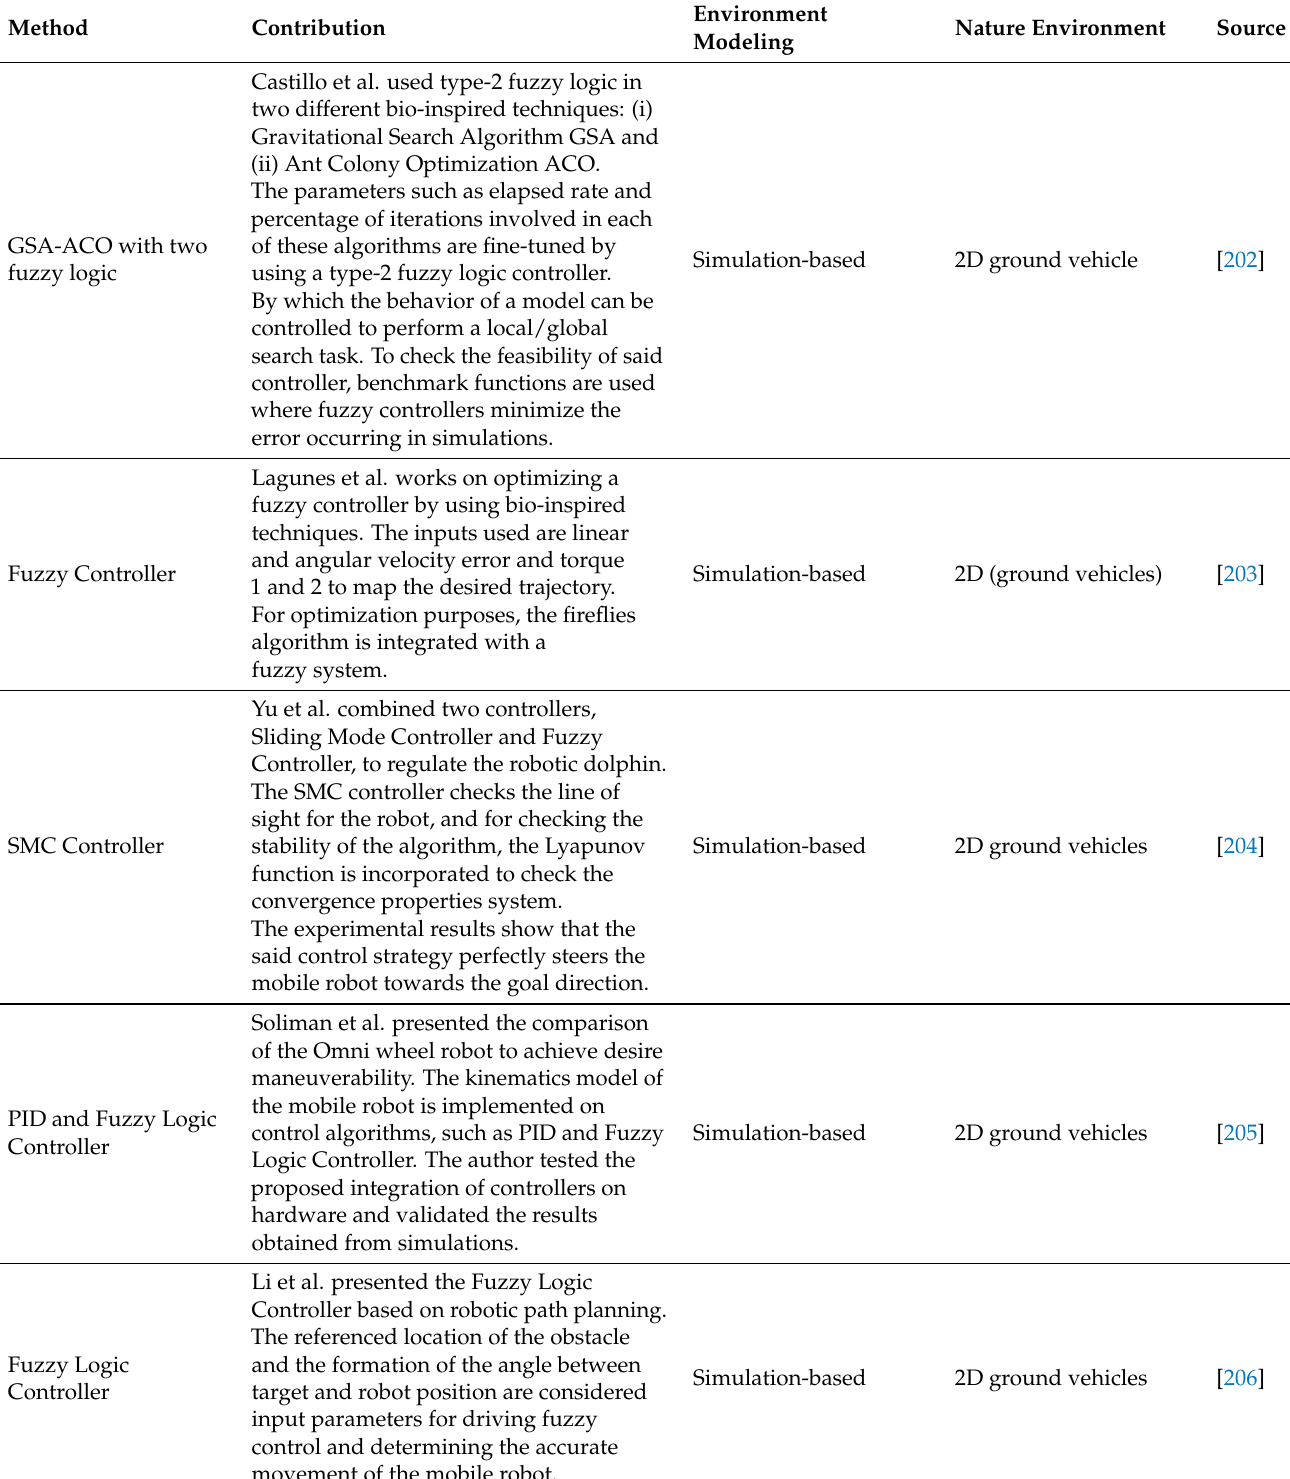
Table 5. The Impact of the Fuzzy Logic Controller Involved in Aerial and Ground